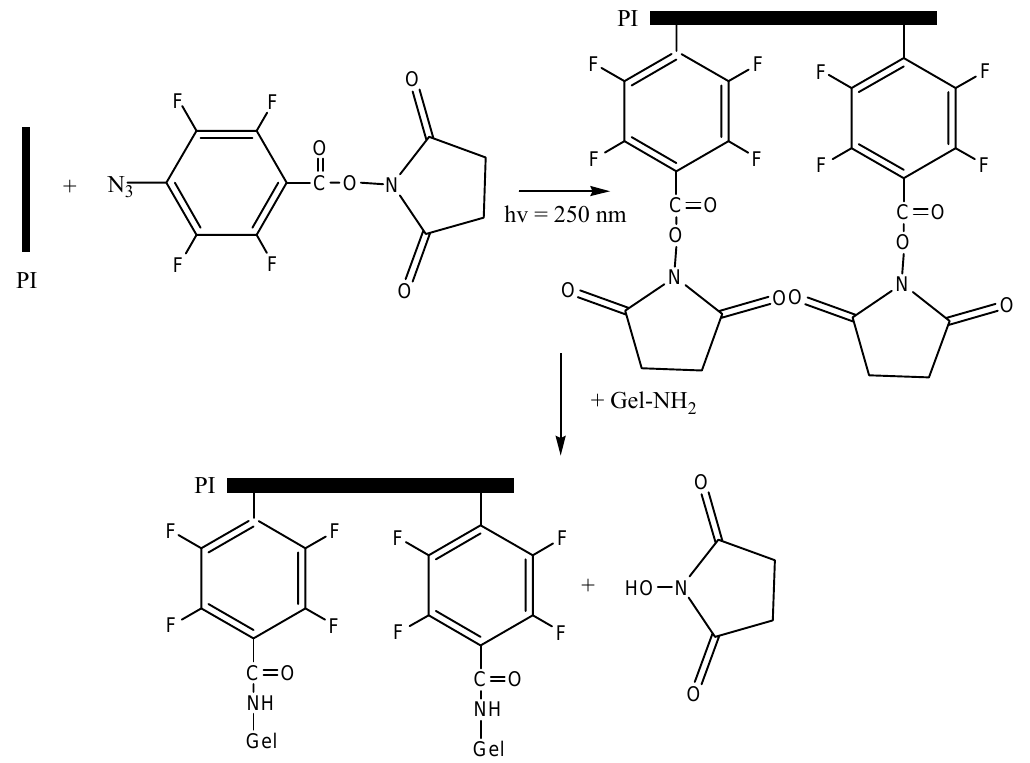
Figure 1. Reaction scheme for the immobilization of gelatin on the PI surface using the succinimidyl ester of